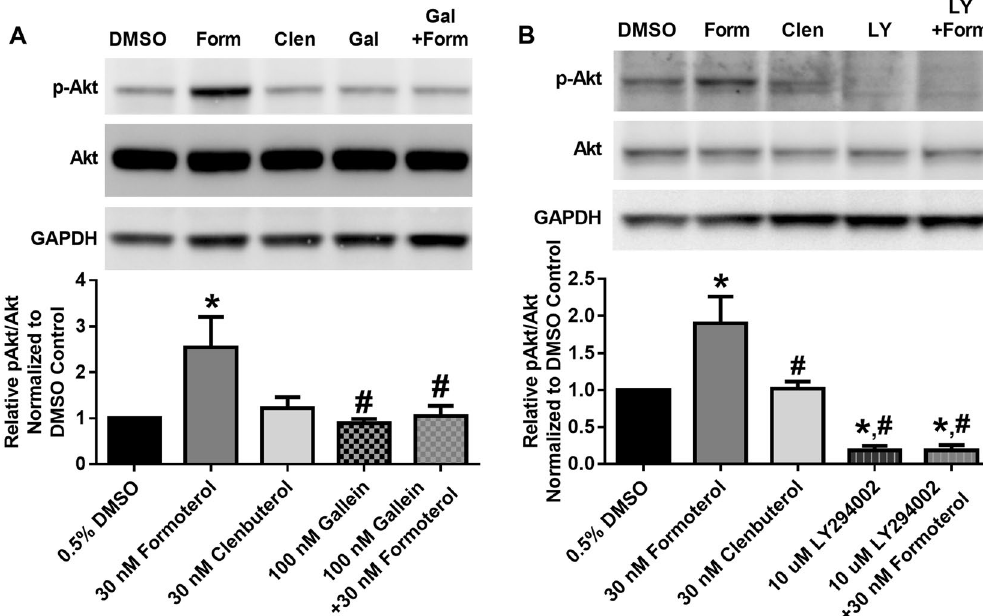
Figure 2. Formoterol, but not clenbuterol, activates Akt in a G βγ -PI3K-dependent manner in RPTC. pAkt was measured following 30 min of formoterol (Form) or clenbuterol (Clen) in the presence and absence of the G βγ inhibitor gallein (Gal)(A, N = 4) or the PI3K inhibitor LY294002 (LY)(B, N = 4–5). Images are cropped to show only relevant bands. Full sized images are available in Supplemental Figure 3. Mean + SEM. * p < 0.05 vs. DMSO, #p < 0.05 vs. formoterol, one-way ANOVA with Sidak’s multiple comparison test.